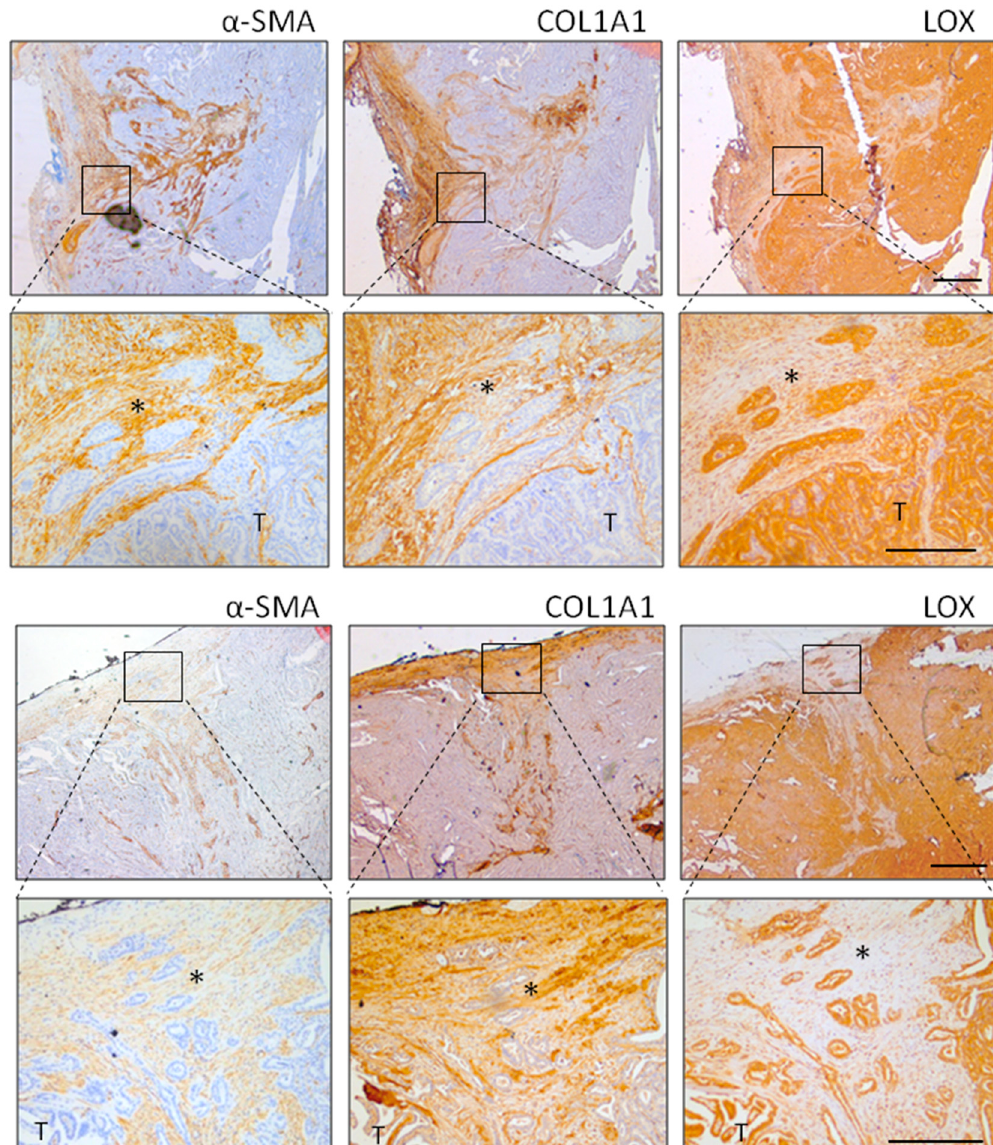
Figure 3. α -SMA, LOX, and COL1A1 immunostaining in human thyroid cancers. Representative thyroid tumors serial sections from two different patients stained by IHC for α -SMA, COL1A1, and LOX protein expression and localization. In the top panel, the tumor edge/invasive front is specifically shown (scale bar 500 μ m), while lower panel has higher magnification (scale bar 200 μ m). * clusters of tumor invading cells detaching from the principal tumor mass (T).